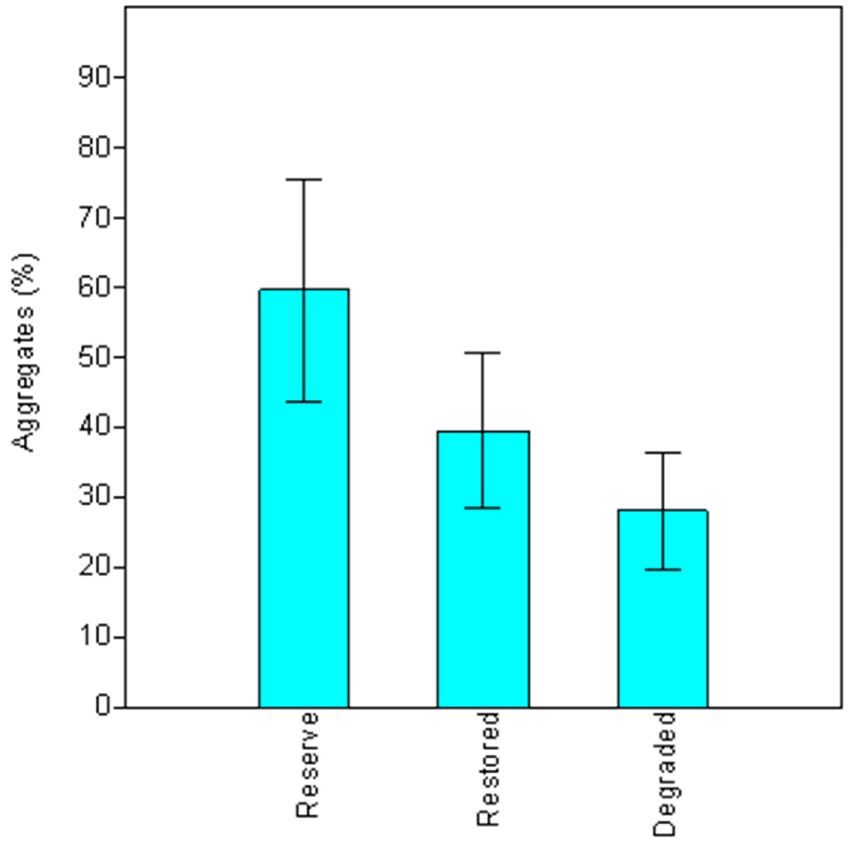
Figure 3. Aggregate content of the soils from riparian sites, Brazil. Bars represent means accompanied by standard errors.